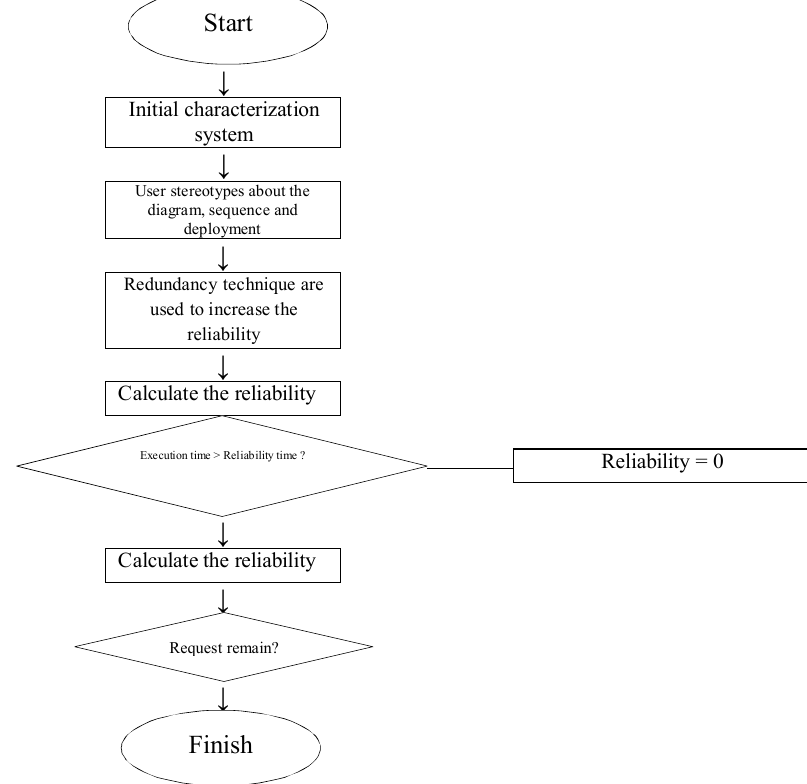
Fig. 1. The flowchart of the proposed